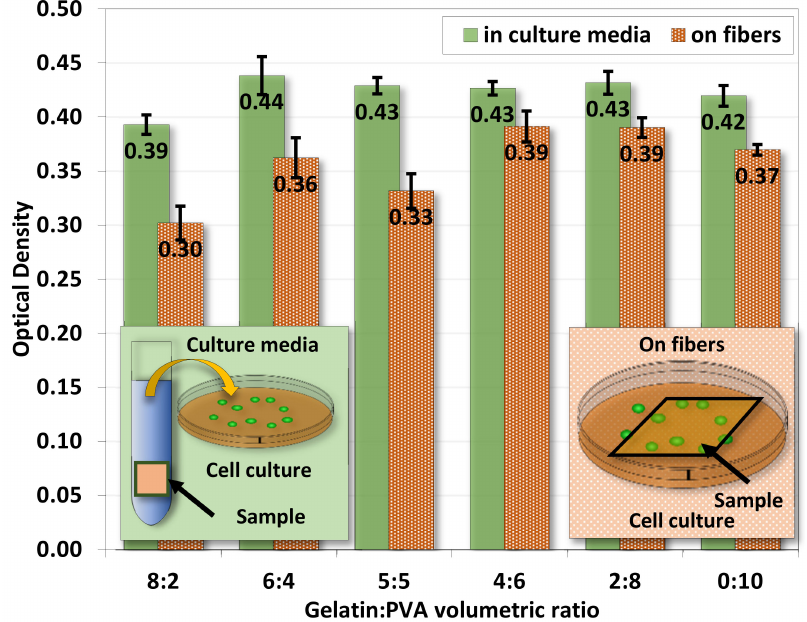
Figure 11. The average optical density from MTT assay for 3T3 cultured in culture media and on gelatin/PVA nanofiber films. The optical density is log